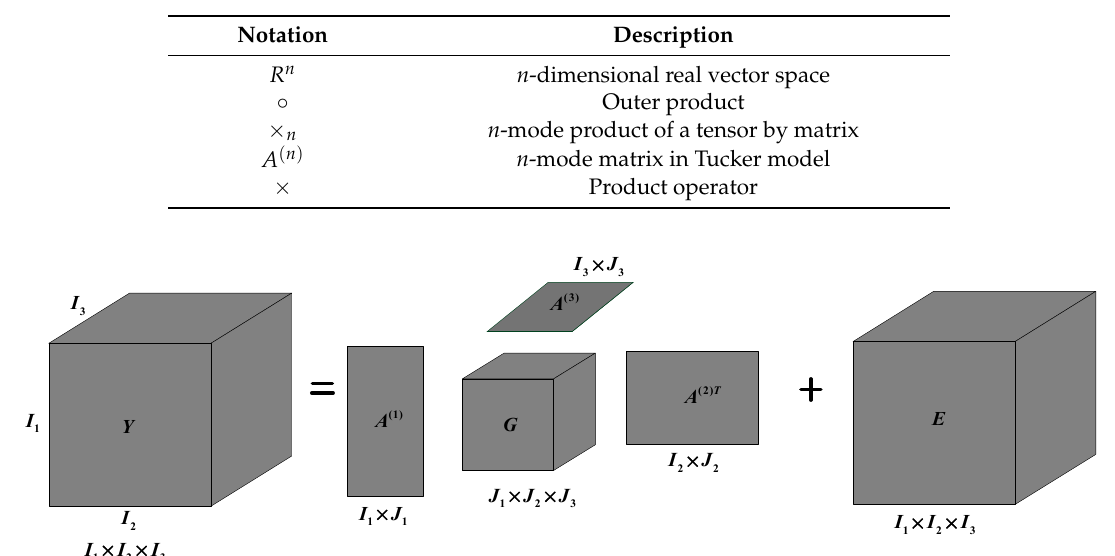
Table 2. Notations of NTD ( nonnegative tensor decomposition ).